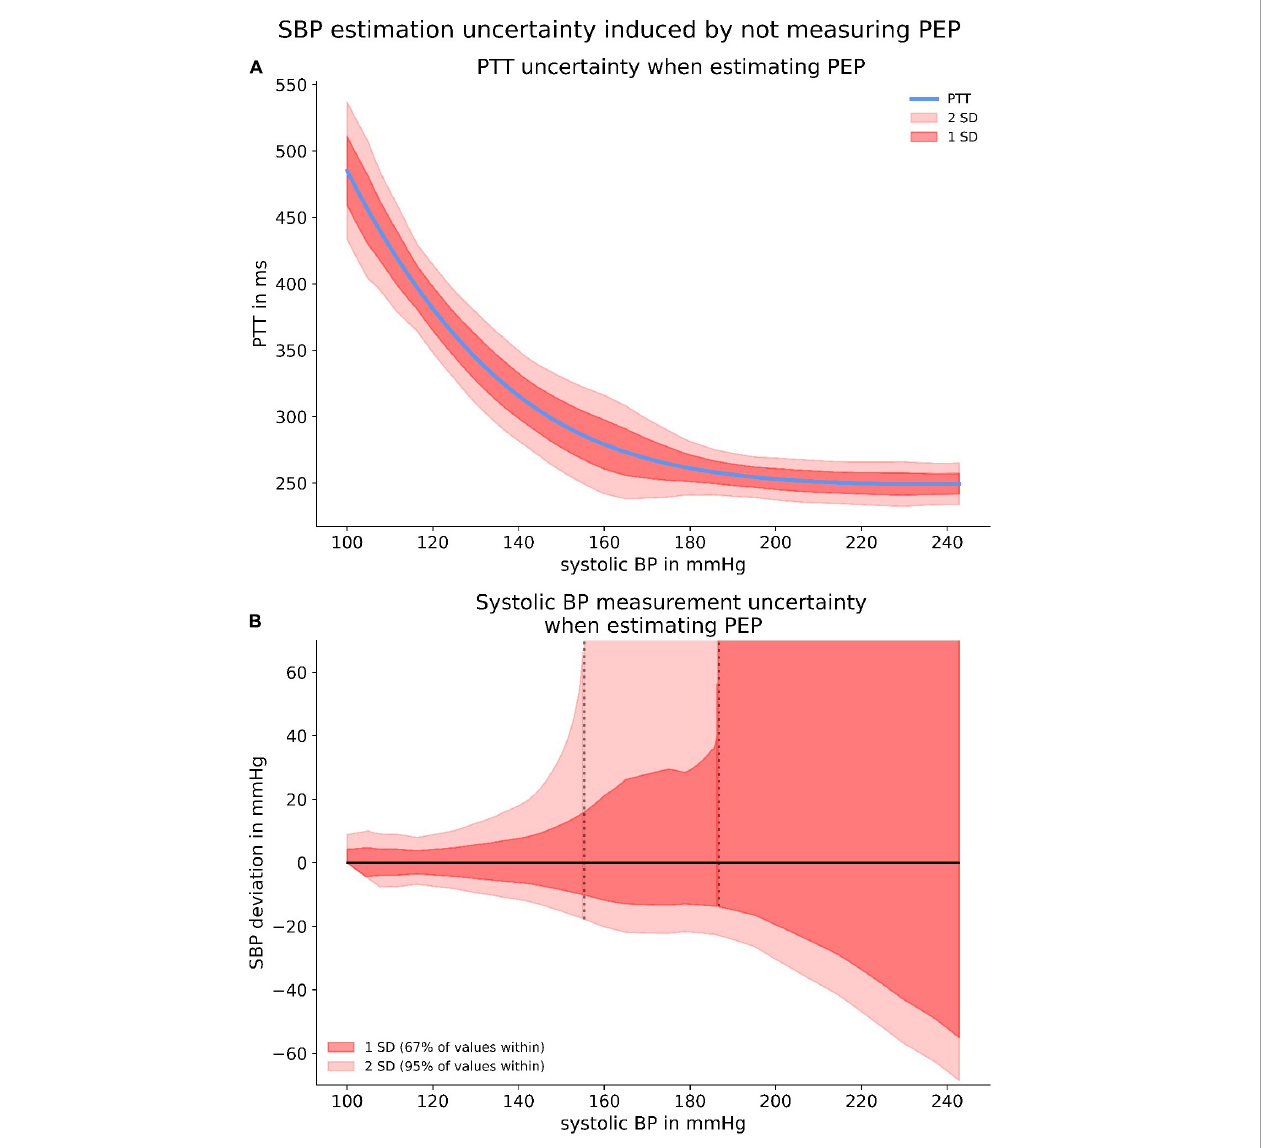
FIGURE10 The upper panel (A) depicts confidence intervals for the PTT-BP relation when estimating PEP. The significant discrepancies are originated from the large PEP variability depicted in Figure 9B . The lower panel (B) highlights the SBP measurement uncertainty induced by estimating PEP with provided confidence